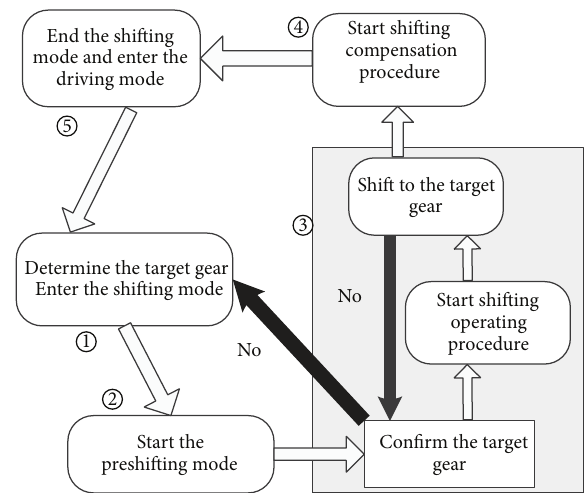
Figure 4: Flow diagram of the gearshift process for the PHEV equipped with